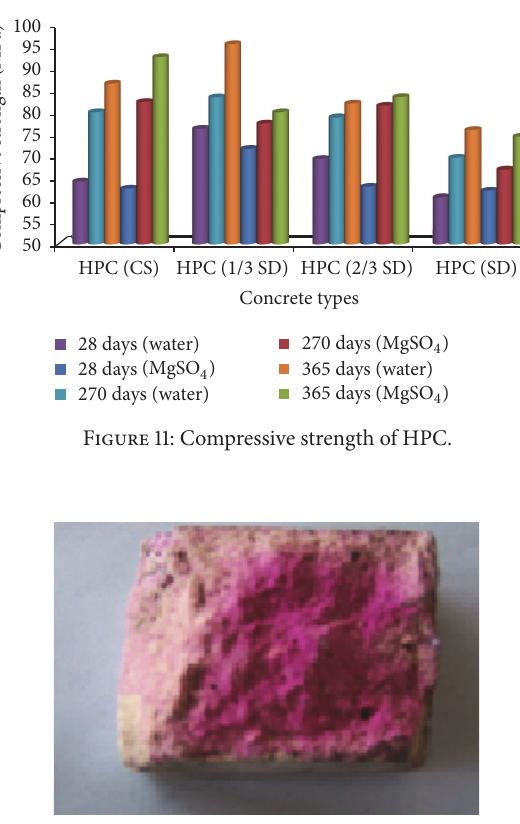
Figure 12: Evolution of pH of